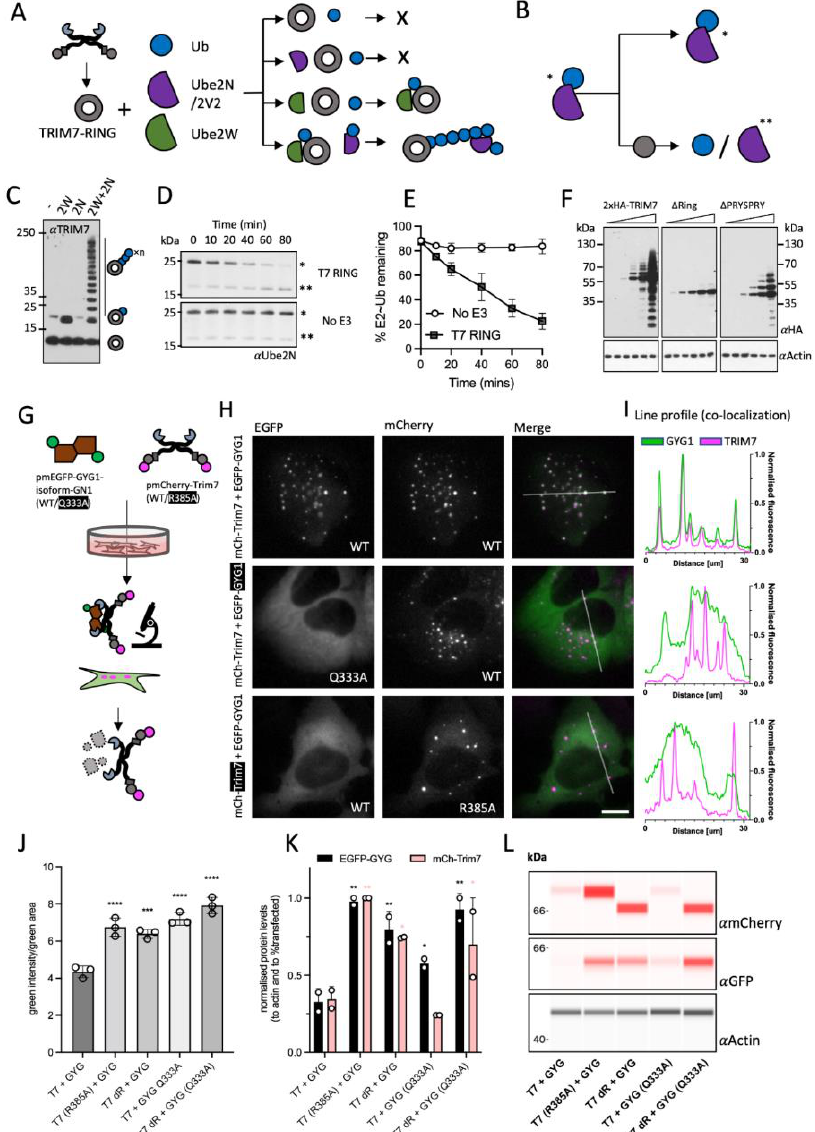
Figure 3. TRIM7 co-localizes with helix- Φ Q containing substrates inside cells and degrades them. ( A – E ) Schematic representation of in vitro ubiquitination experiments. ( A ) TRIM7-RING (grey circle) was mixed with combinations of Ubiquitin (Ub, blue circle), Ube2N/Ube2V2 (purple semi-circle) and Ube2W (green teardrop) as shown and the reactions followed by immunoblotting ( C ) with an anti- TRIM7 antibody. A representative blot from at least three independent experiments is shown. ( B ) E2 discharge experiment: Ube2N~Ub complex was incubated with TRIM7-RING, and the reaction followed over time as indicated in ( D ). Blots were probed with anti-ubiquitin antibody. A single asterisk denotes the charged Ube2N~Ub, whereas a double asterisk denotes the uncharged Ube2N. A representative blot from at least three independent experiments is shown. ( E ) Densitometry quantification of band intensities from 3D was plotted to show the kinetics of E2-Ub discharge. Error bars in all graphs depict the mean +/ − SEM. Data represent three independent replicates. ( F )